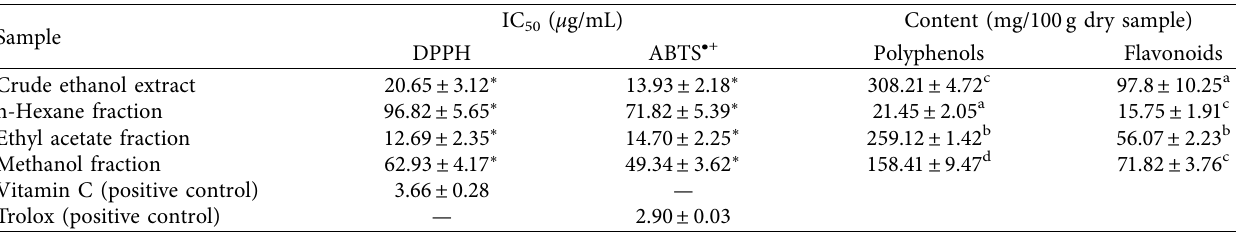
Table 1: The antioxidant activity, total polyphenols (TPs), and total flavonoids (TFs) content of crude ethanol extract and its derived